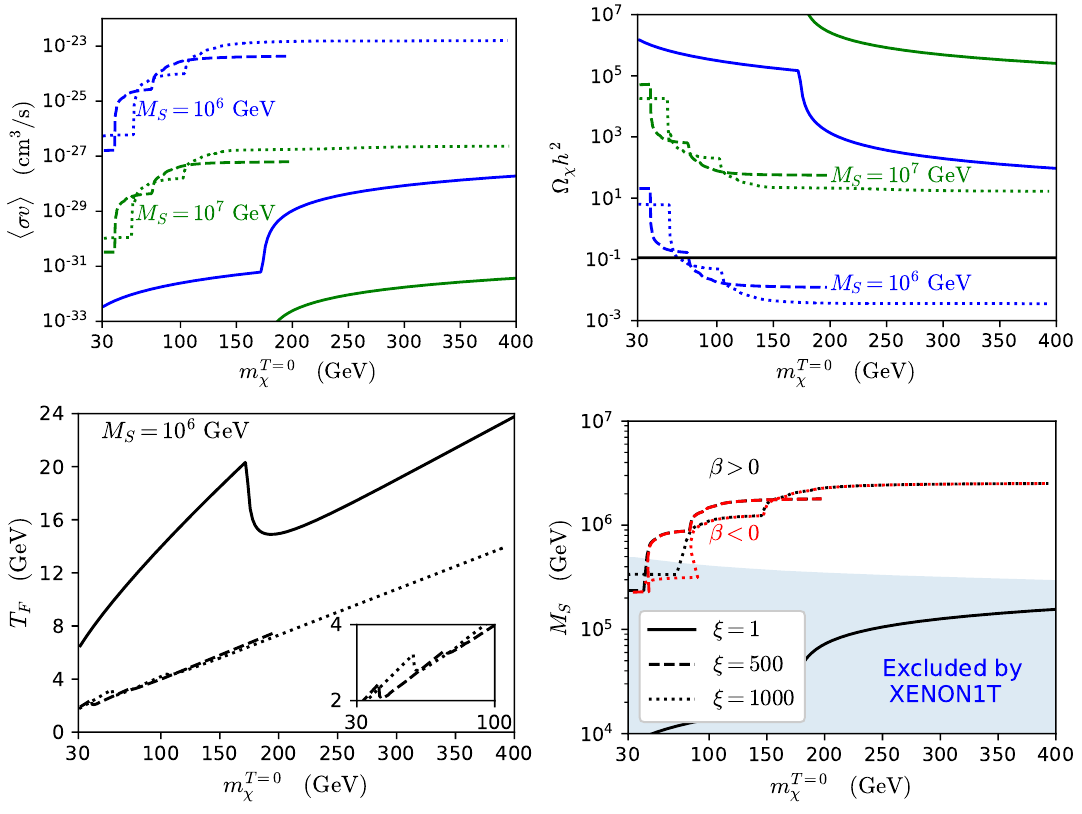
Figure 4 . (Top left) The thermally-averaged cross-sections at the time of freeze-out as a function of m T =0 plotted for M S = 10 6 GeV (blue), 10 7 GeV (green) and (cid:24) =1 (solid), 500 (dashed), 1000 (cid:31) (dotted). (Top right) Dark matter relic abundance today as a function of m T =0 10 6 GeV (blue), 10 7 GeV (green) and (cid:24) = 1 ; 500 ; 1000. The horizontal solid line is the observed dark matter abundance. (Bottom left) The freeze-out temperature T F as a function of m T =0 M S = 10 6 GeV ; 10 7 GeV plotted for (cid:24) =1 (solid), 500 (dashed), 1000 (dotted). (Bottom right) We show the M S values that produce the observed dark matter relic abundance as a function of m T =0 for (cid:24) =1 (solid), 500 (dashed), 1000 (dotted). For (cid:12) < 0, the line is plotted in red. Shaded blue region is excluded by XENON1T. See text for